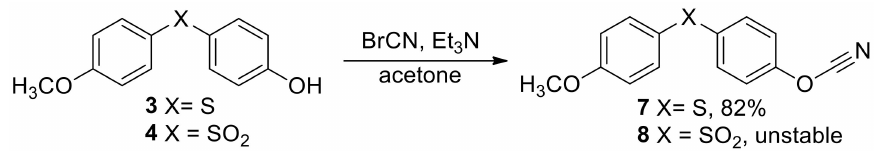
Figure 3. Synthetic route to monocyanate esters 7 and 8 .